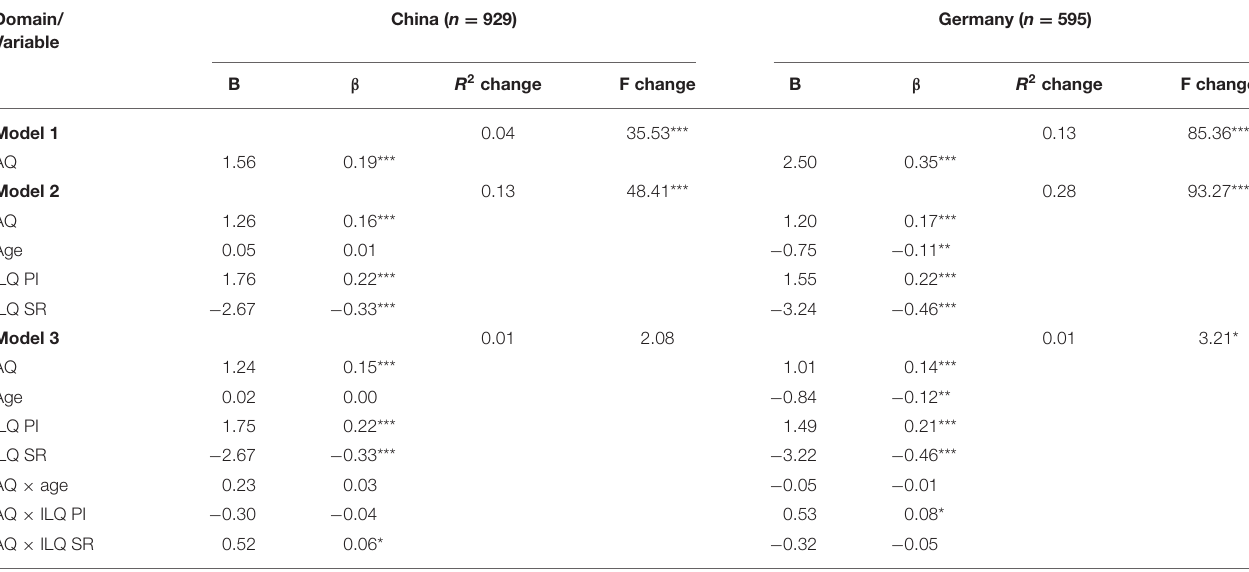
TABLE 7 | Regression coefficients of the moderated regression analyses with s-IAT total scores as a dependent variable, AQ total scores, age and ILQ dimensions as independent variables. Domain/